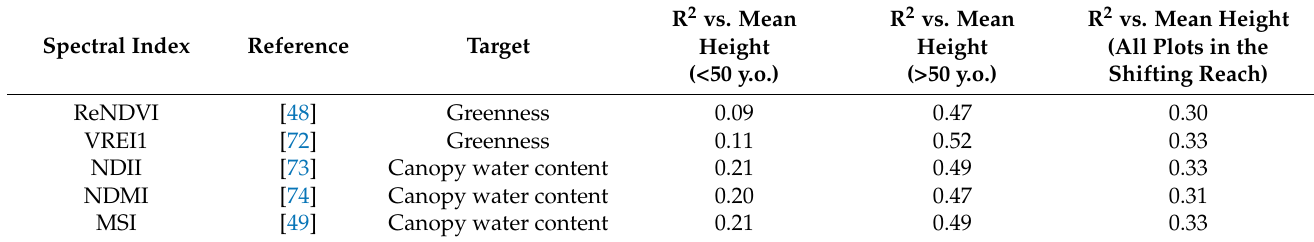
Table 6. The five hyperspectral indexes showing the strongest correlation with canopy height for plots older than 50 years, and their correlation coefficients with forest plots younger than 50 years, forest plots older than 50 years, and all forest plots located in the well-connected shifting